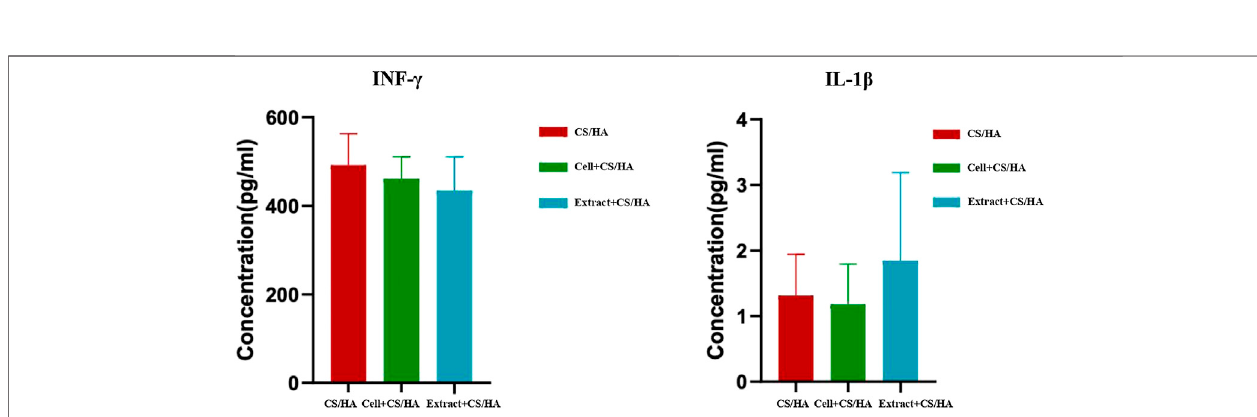
FIGURE 6 | Comparison of INF- γ and IL-1 β levels among wounds treated with CS/HA, extract + CS/HA, and cell + CS/HA at 14 days post-wounding. No notable changes in INF- γ and IL-1 β levels in the mice treated with cell + CS/HA and extract + CS/HA.